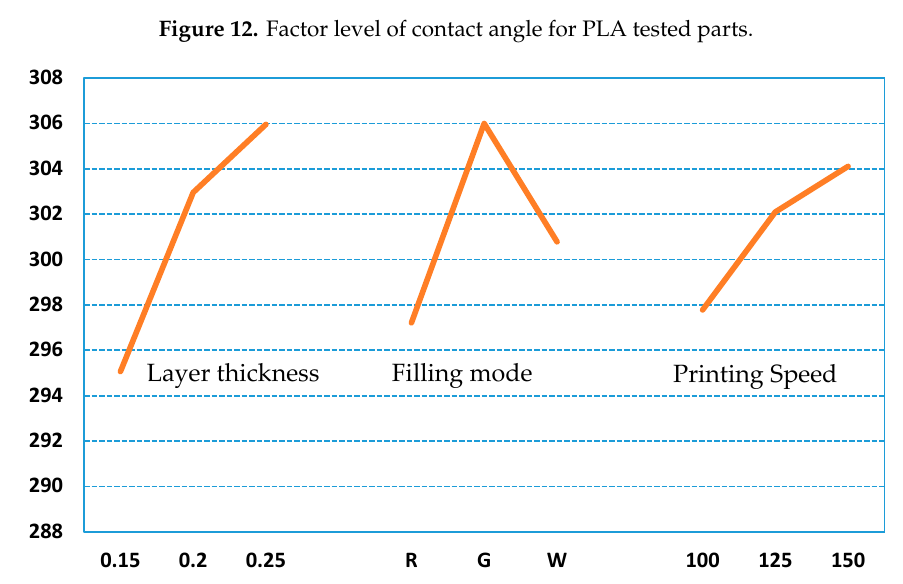
Figure 13. Factor level of contact angle for ABS tested parts .